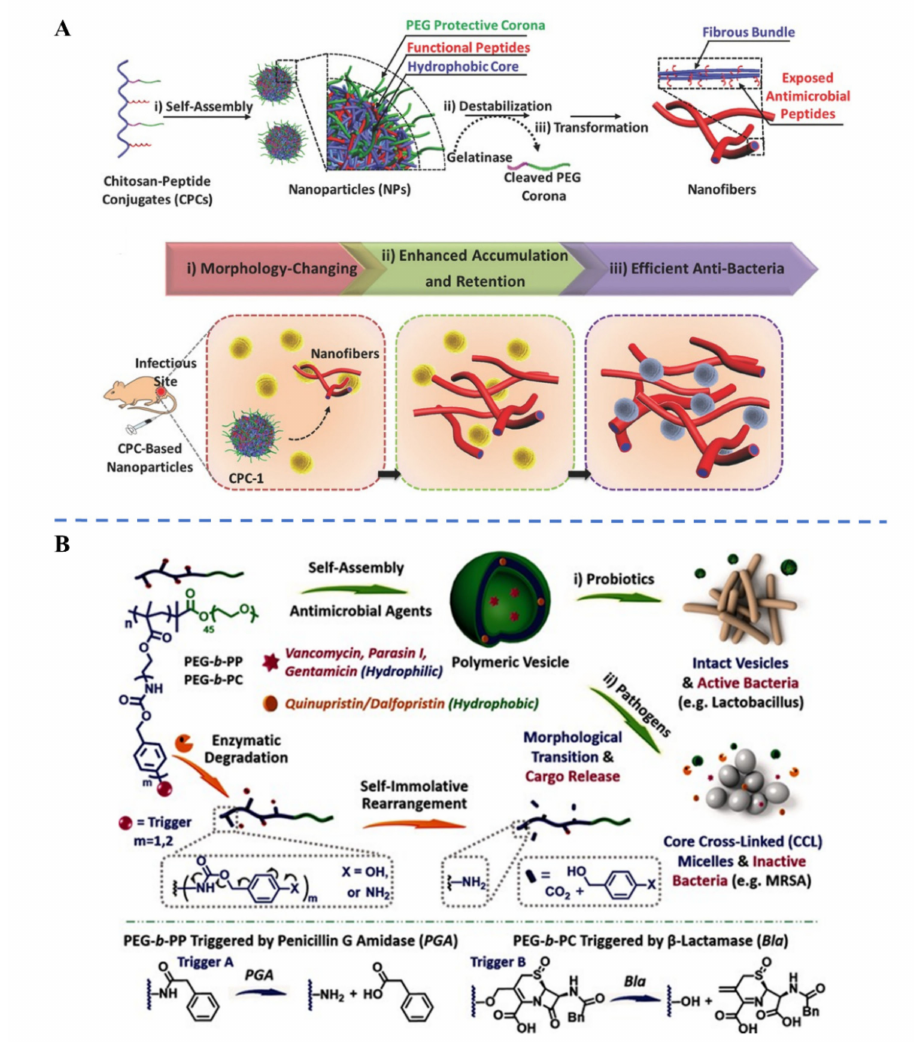
Figure 5. Examples of enzyme-responsive nanocarriers for antibiotic delivery. ( A ) Illustration of the self-assembly of polymer–peptide conjugate NPs and the principle of enzyme-induced morphology transformation with the high antibacterial ability (reprinted with permission from [60], copyright 2017 John Wiley and Sons). ( B ) Illustration of enzyme-responsive polymeric vesicles for bacterial strain- selective delivery of antibiotics. Polymeric vesicles are self-assembled from synthesized polymers subjected to side-chain cleavage and microstructural transformation in response to penicillinG amidase and β -lactamase. This process is accompanied by sustained release and bioactivity recovery of encapsulated antibiotics (reprinted with permission from [61], copyright 2016 WILEY-VCH Verlag GmbH & Co. KGaA,